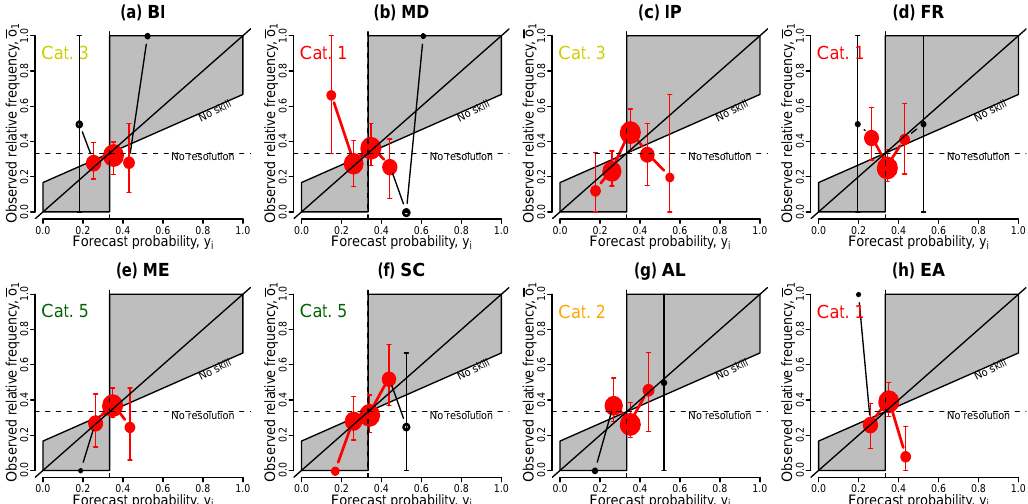
Figure 16. Reliability diagrams for high winter precipitation, defined as seasonal DJF averages in the upper tercile. See the caption of Fig. 13 for technical